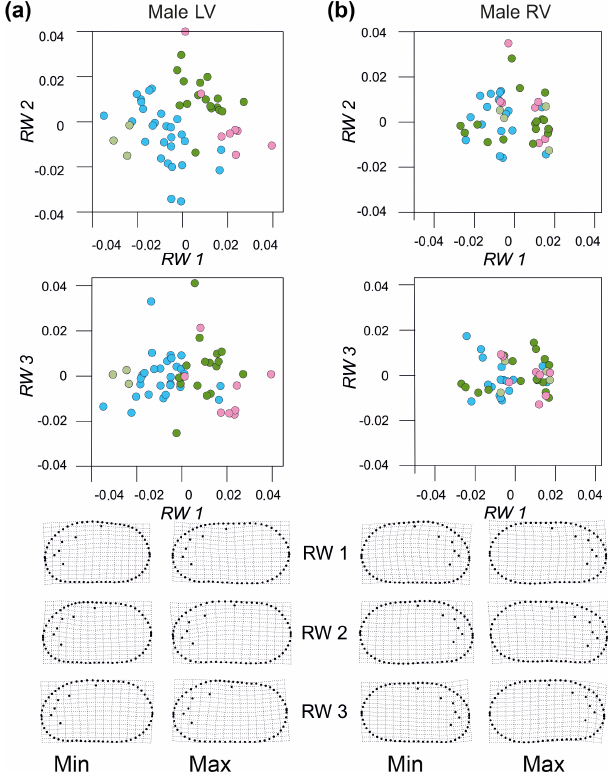
Figure 3. Relative warp analyses of left (a) and right (b) valves of males of the first three warps and the associated thin-plate splines at minimum and maximum scores. Colours refer to the different regions (blue – Florida, green – Mexico, light green – Lake Punta Laguna, pink – Brazil).